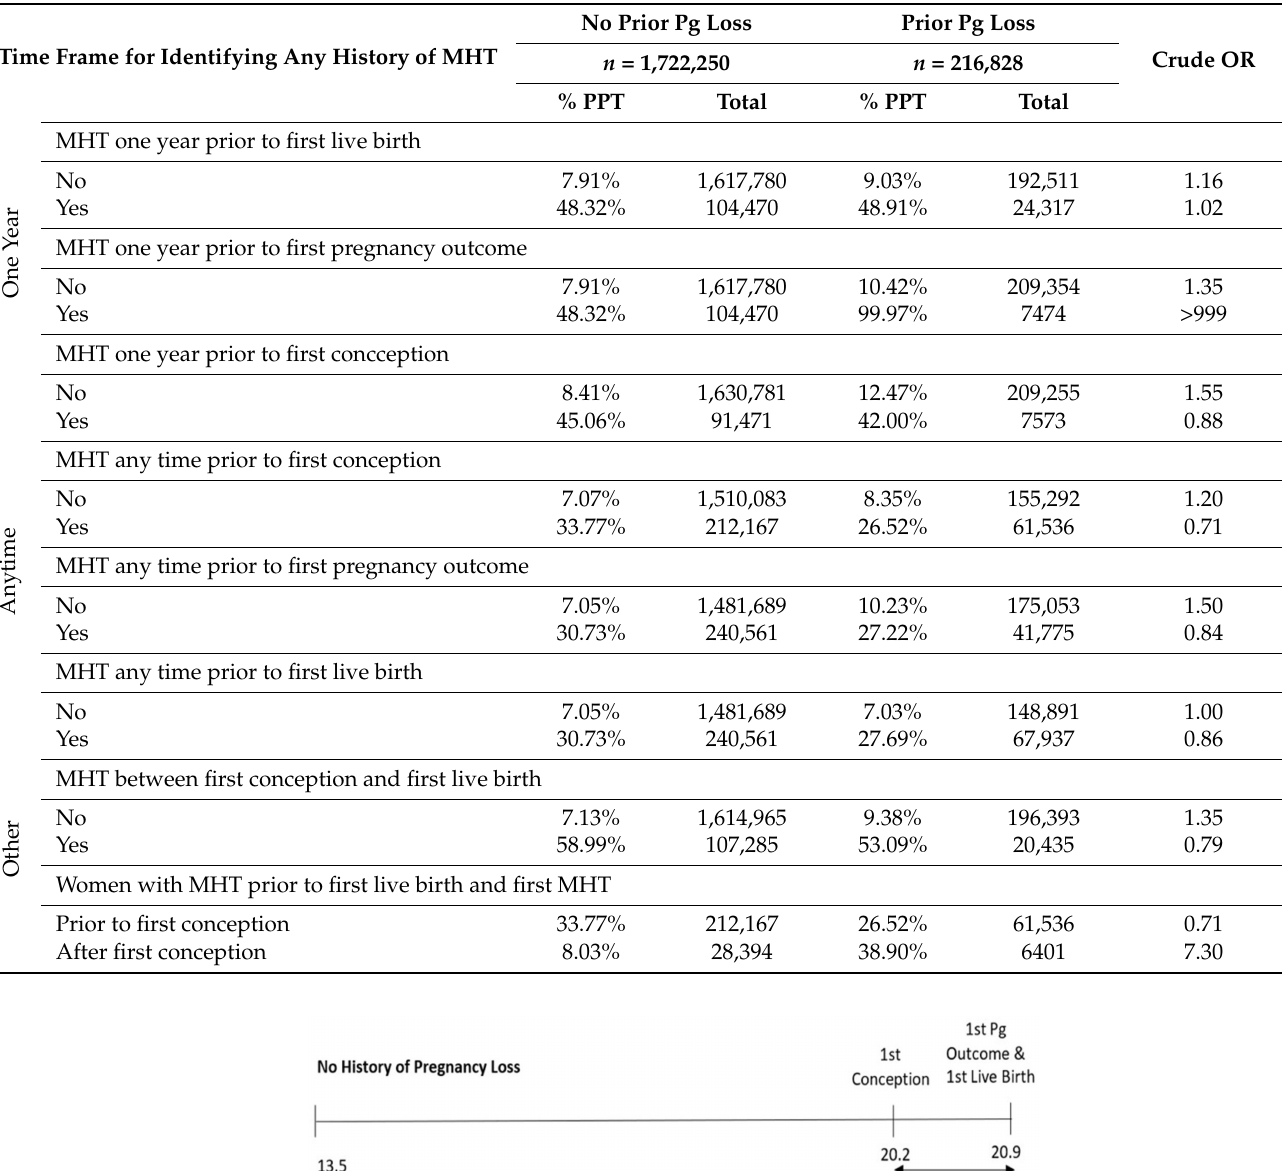
Table 2. Women with postpartum psychiatric treatments (PPT) relative to first pregnancy outcome (birth or loss) and history of mental health treatments (MHTs) prior to specific pregnancy associated dates.